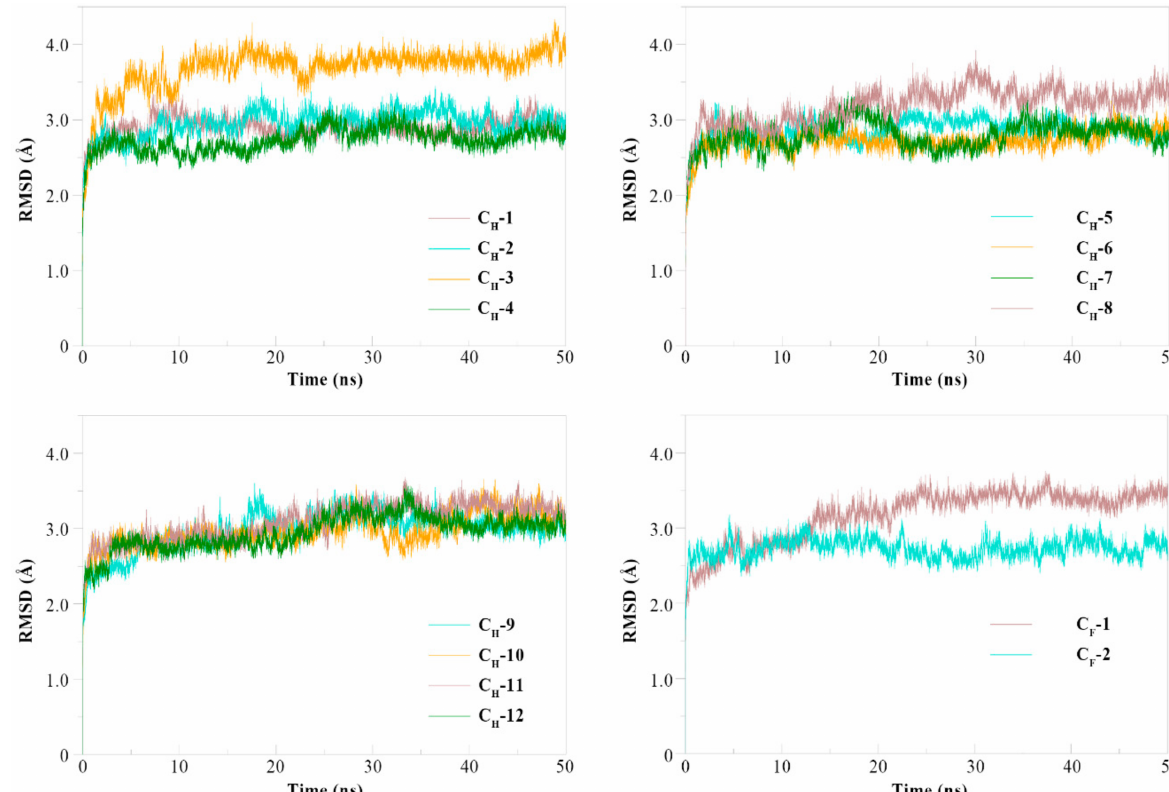
Figure 3. The root-mean-square deviation (RMSD) values for carbon backbones of SnocOBP12–ligand complexes during the 50 ns molecular dynamics (MD)